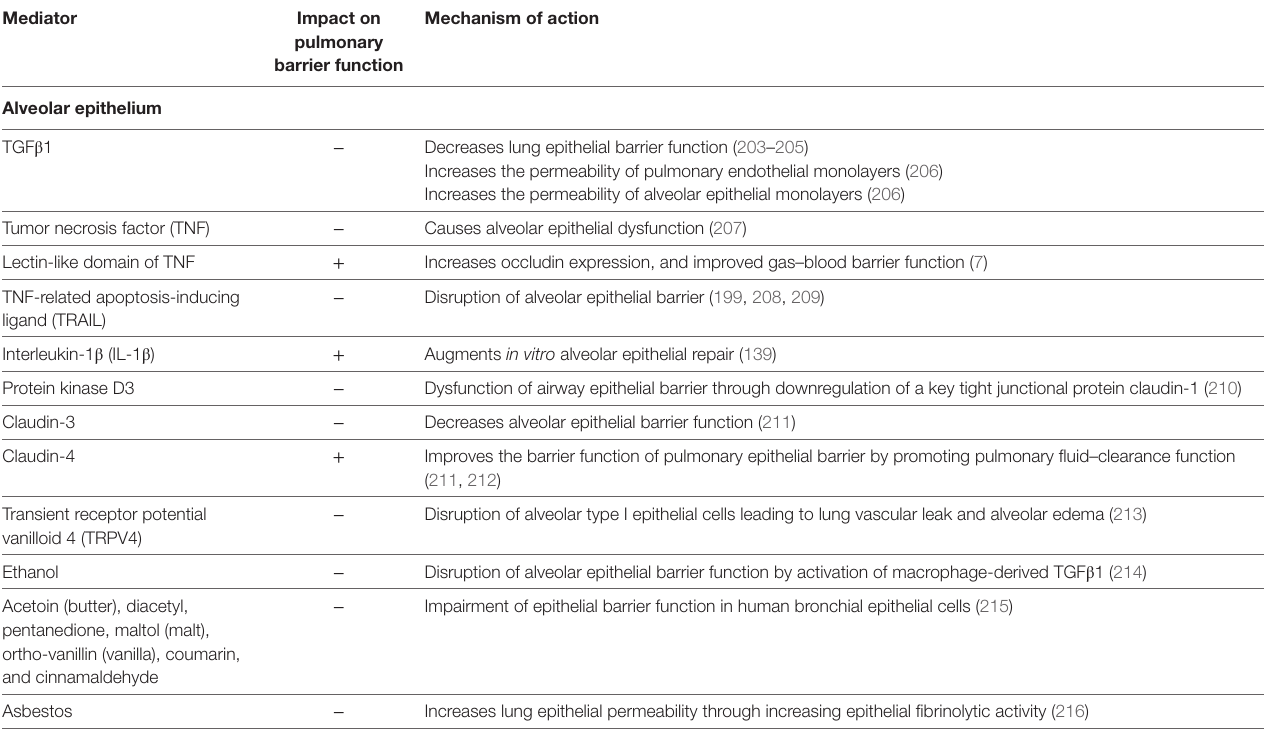
TAbLe 2 | Impact of different factors on the alveolar–capillary barrier. Mediator impact on pulmonary barrier